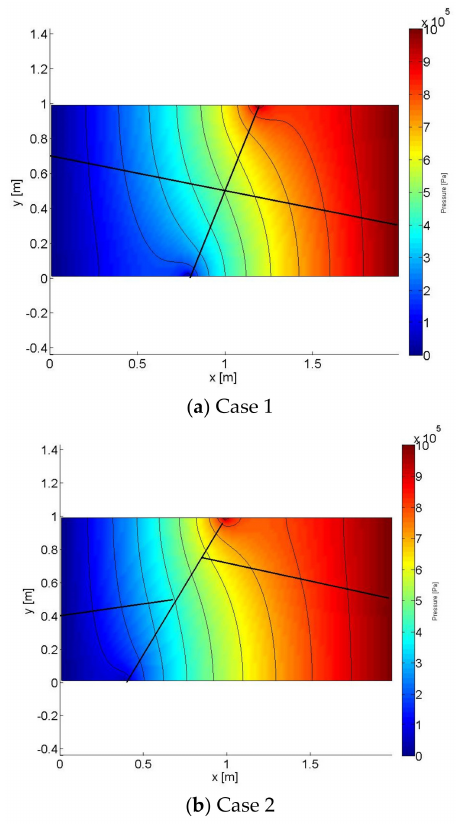
Figure 4. Pressure distribution of two